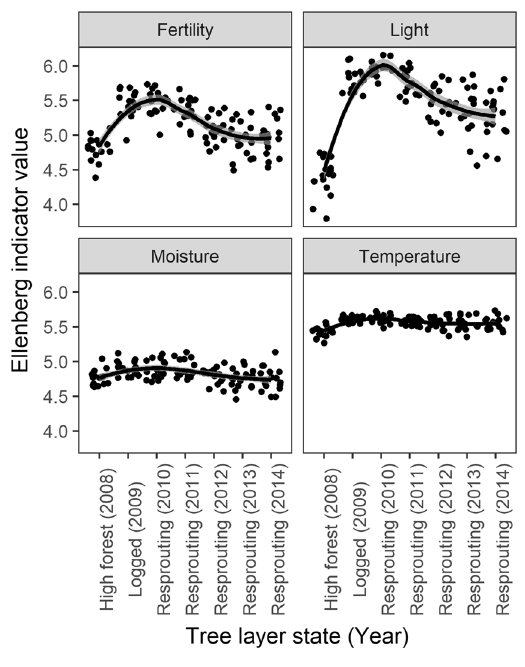
Figure 4. Temporal dynamics of Ellenberg indicator values for environmental variables over the study period (2008–2014). Solid lines within the grey bands represent a fitted LOESS model with 95% confidence intervals.